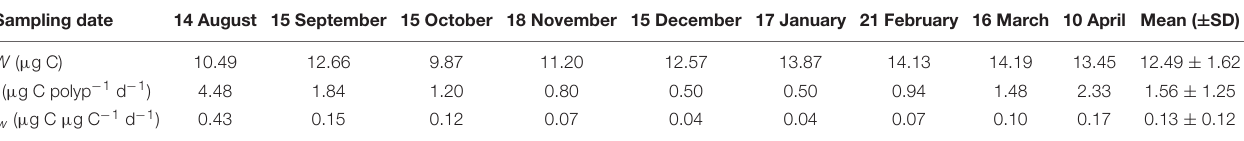
TABLE 4 | Ingestion rates ( I , µ g C polyp − 1 d − 1 ) and carbon weight-specific ingestion rates ( I w , µ g C µ g C − 1 d − 1 ) of A. coerulea polyps from August 2018 to April